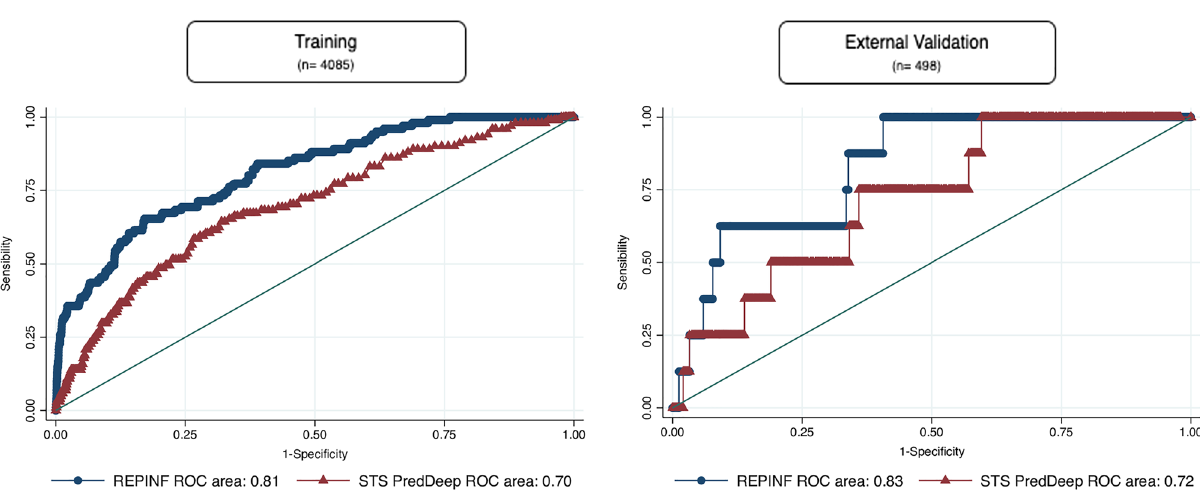
Figure 1. Receiver operating characteristic curve (ROC; c-index) in the external validation sample of the REPINF and STS in patients undergoing isolated CABG. Sao Paulo, Brazil, 2017–2019.